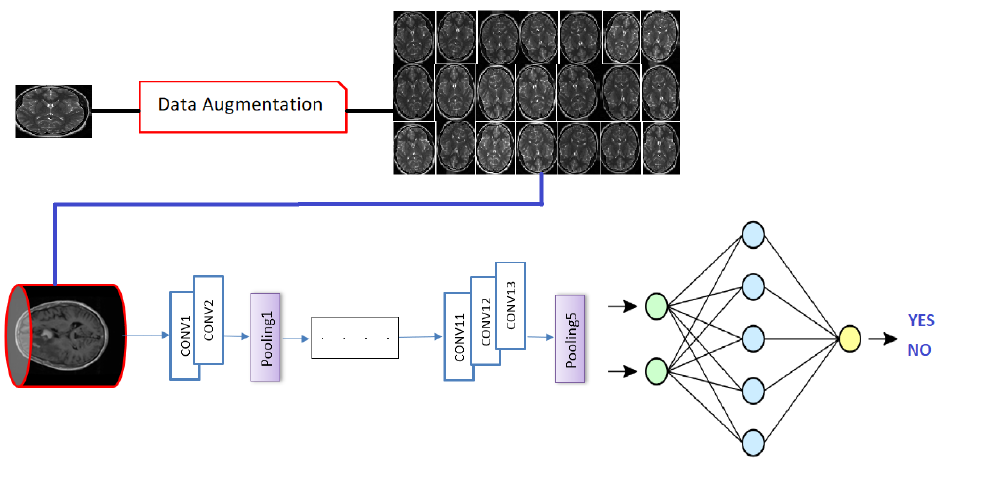
Figure 7. Flowchart of the